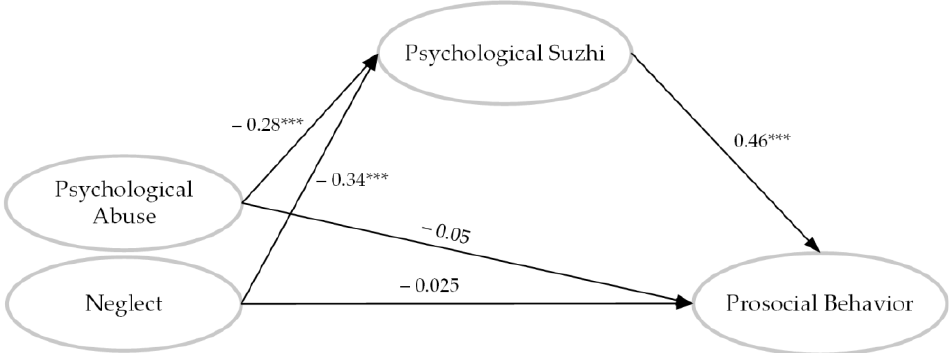
Figure 3. The mediation role of psychological suzhi in the relationship between psychological abuse and neglect with prosocial behavior. *** p < 0.001.